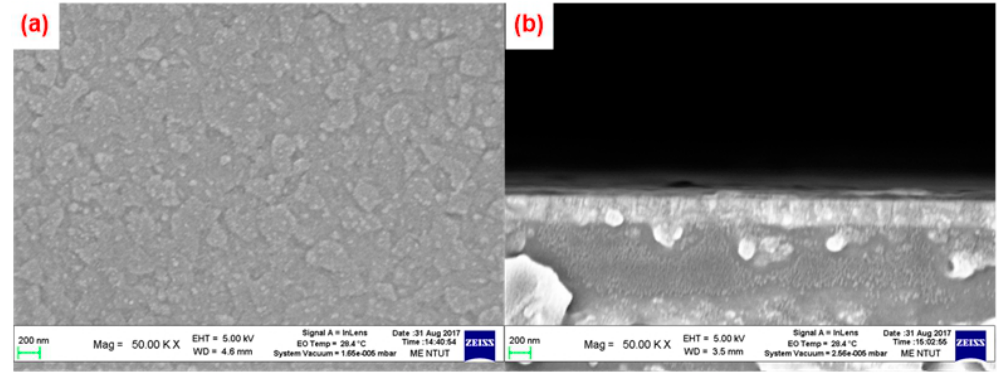
Figure 3. ( a ) Top and ( b ) cross-sectional scanning electron microscopy (SEM) images of CsPbBr 3 -QDs on ITO glass substrate. on ITO glass